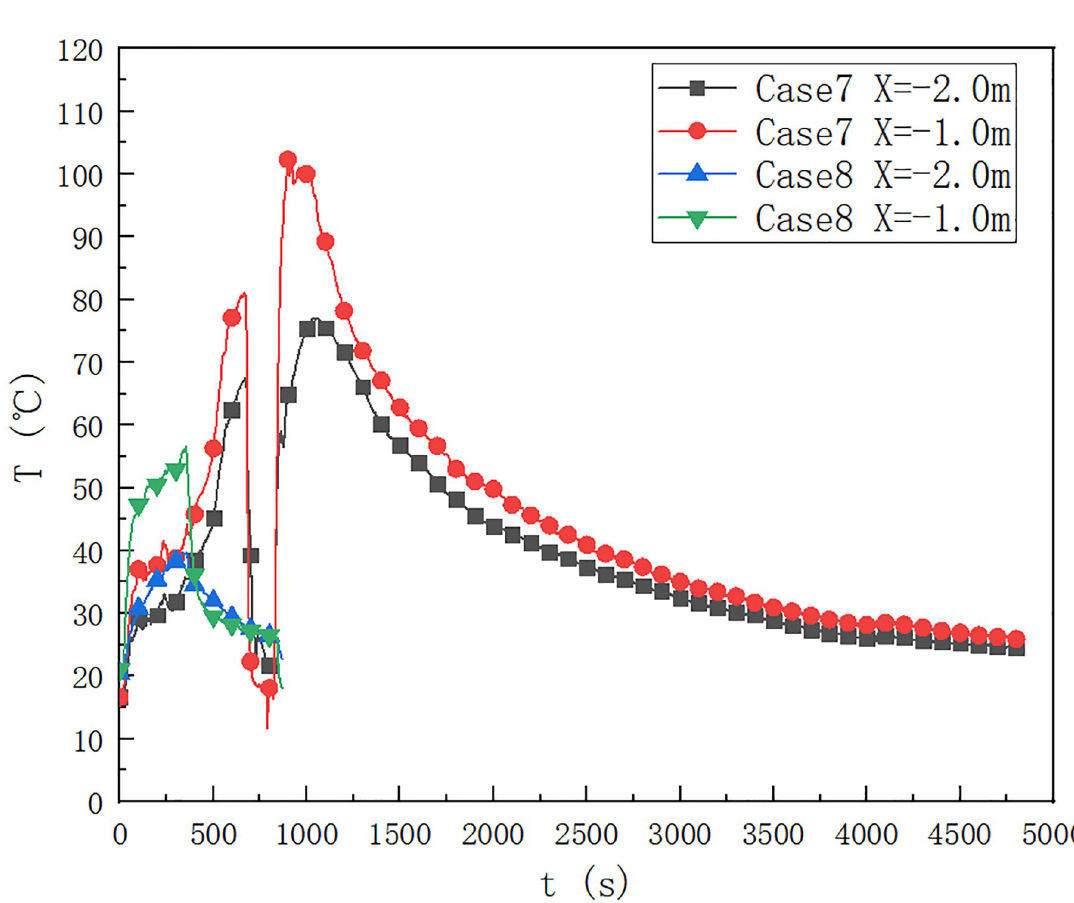
Fig 12. Temperature below the ceiling of the cable compartment in utility tunnel at 7 and 8 at a distance of -1.0 m and -2.0 m from the fire